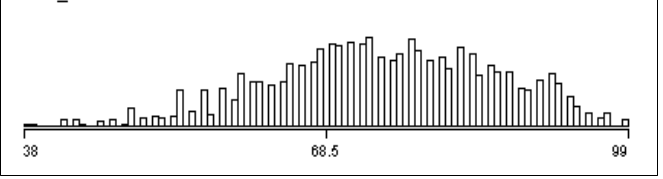
Figure 6: Graphic of the Relative humidity % during the period of analysis.